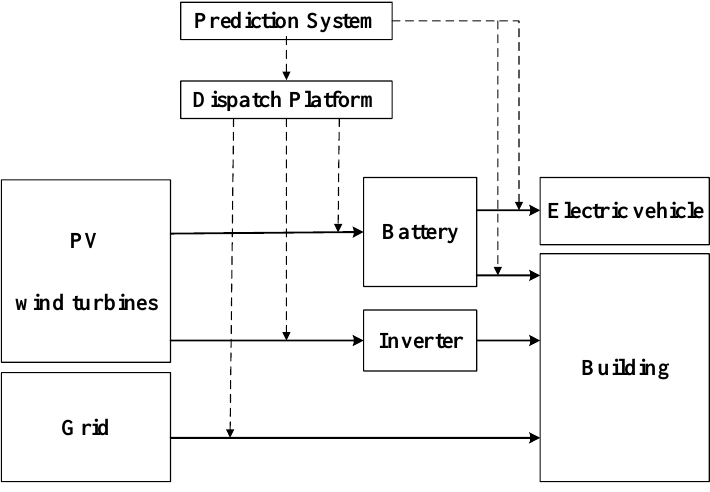
Figure 1. The residential building renewable energy system. Table 1. The composition of the building renewable energy system.